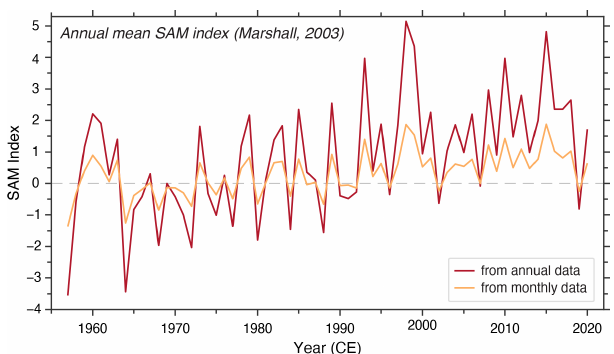
Figure 2. Difference in the observed annual SAM index when calculated using monthly MSLP anomalies (i.e. using normalised monthly MSLP anomalies at 40 and 65 ◦ S and then averaging this monthly SAM index into an annual time series; orange line) and an- nual MSLP (i.e. normalised MSLP anomalies at 40 and 65 ◦ S; red line). Data are from Marshall (2003), and the updated index is pub- licly available (http://www.nerc-bas.ac.uk/icd/gjma/sam.html, last access: 14 April